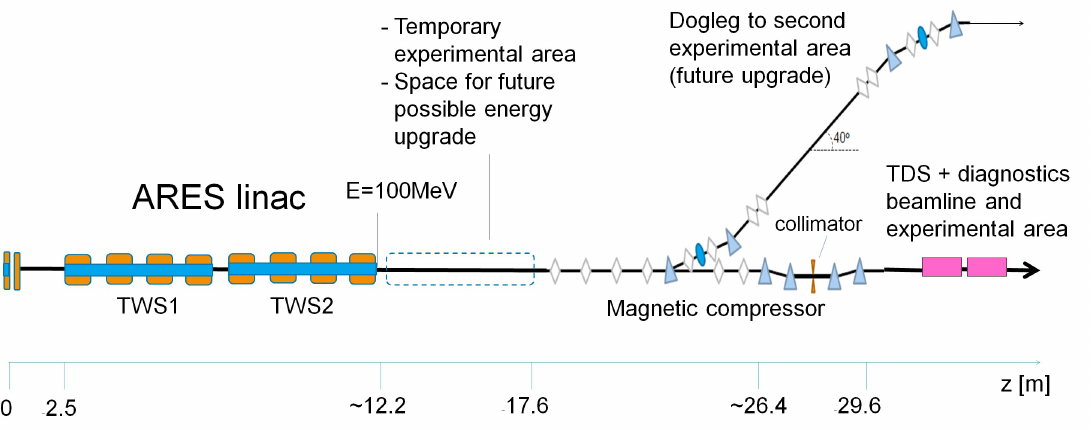
Figure 6. Sketch of the SINBAD-ARES